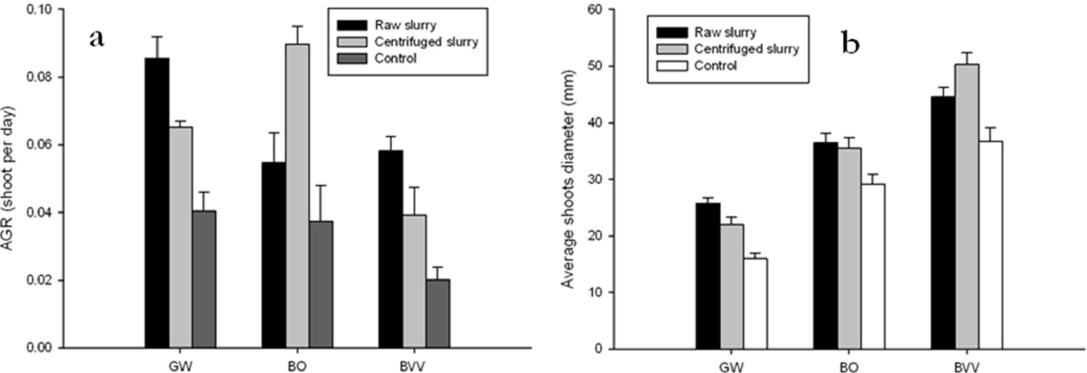
Figure 2. Average absolute growth rate ( a ) and average shoot diameter ( b ) by species and treatment plot; Gigantochloa wrayii (GW) , Bambusa oldhamii (BO) , Bambusa vulgaris (BVV).